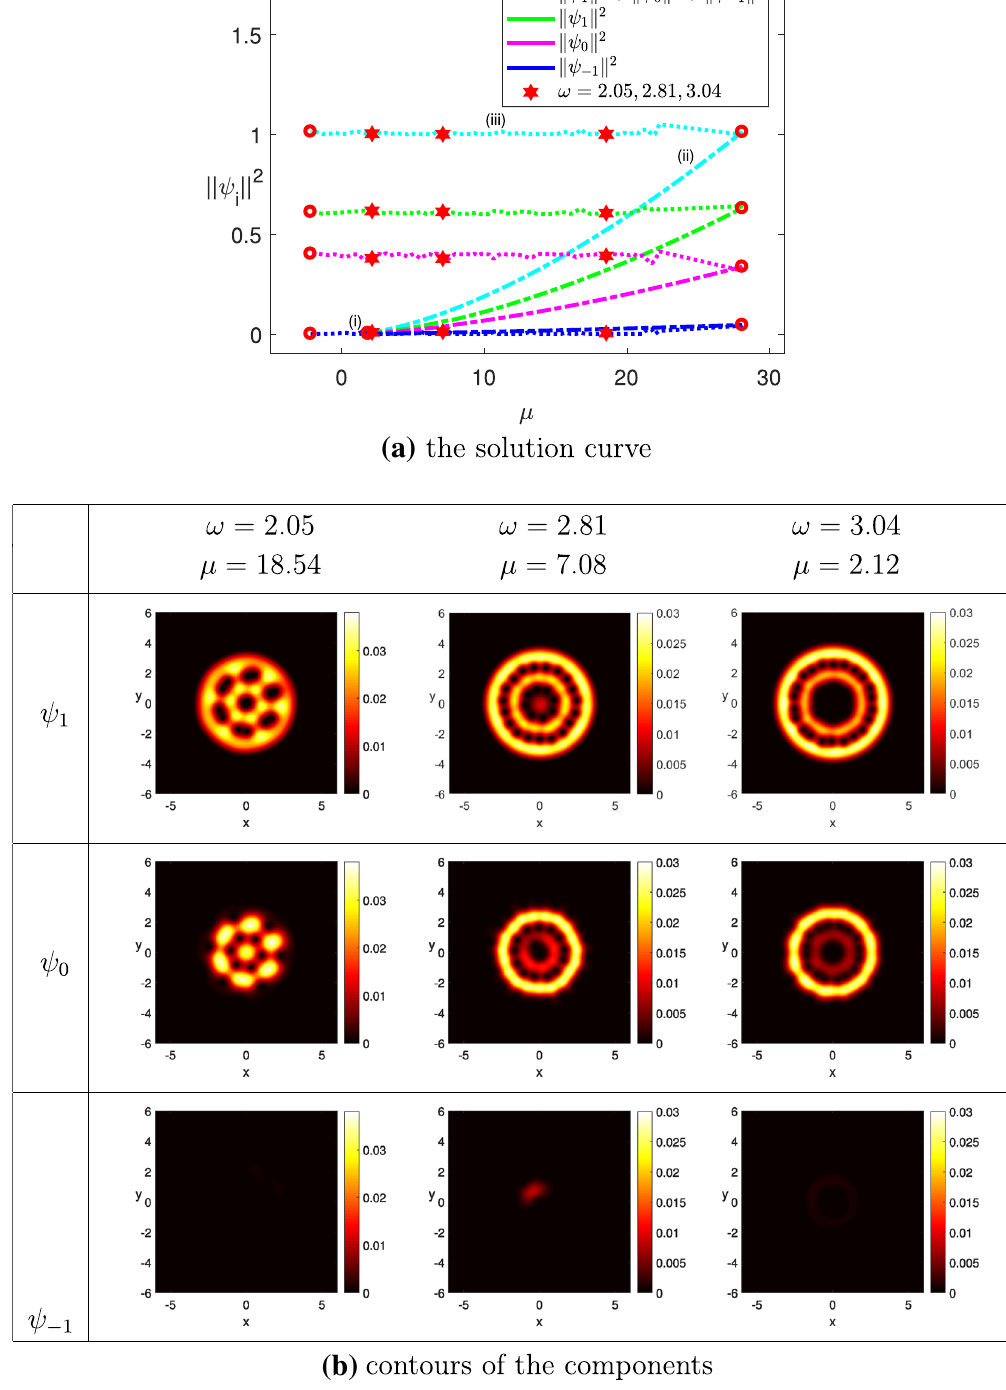
87 Rb , where k 0